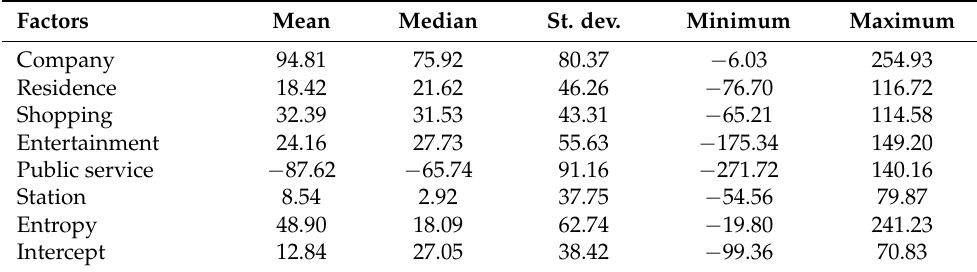
Table 4. The statistical descriptions of regression